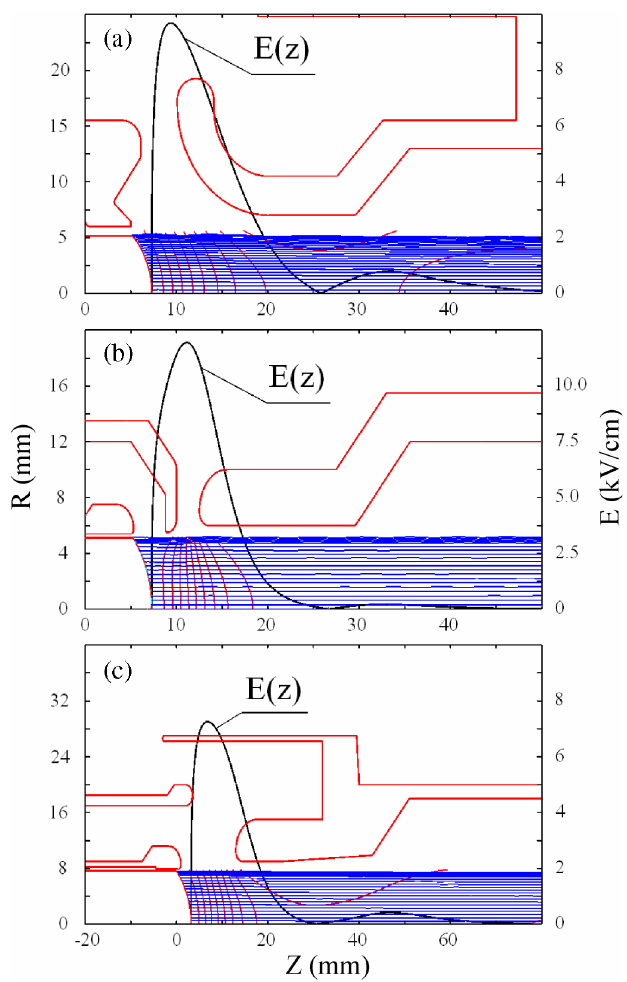
FIG. 8. (Color) Gun geometry and ‘‘ ULTRASAM ’’ code electric field simulation results for: (a) flattop gun; (b) Gaussian gun; (c) SEFT